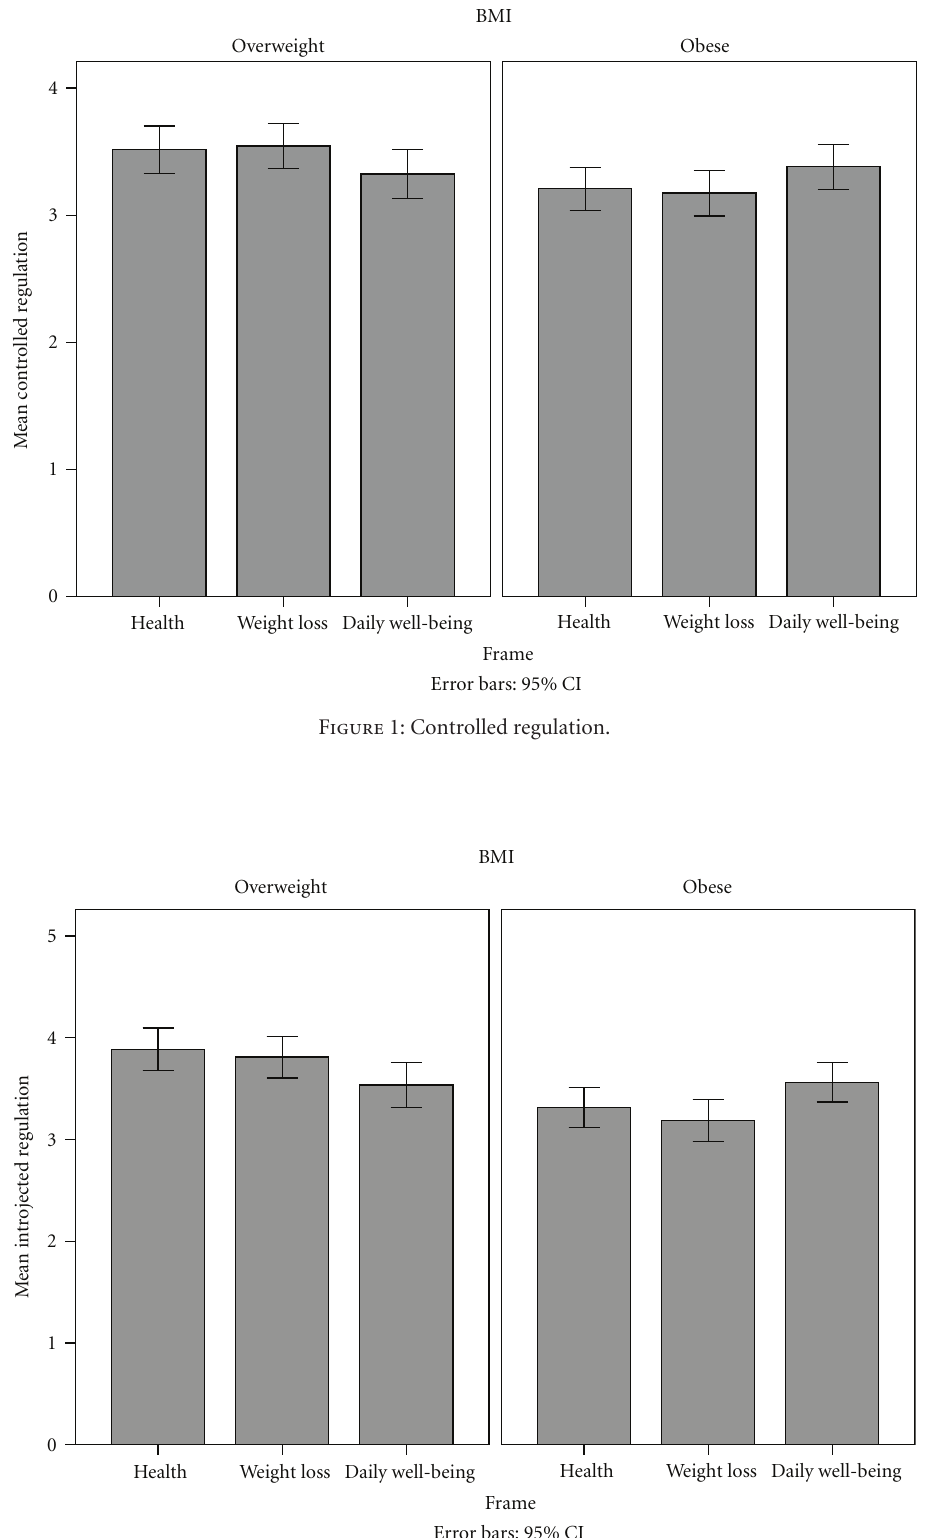
Figure 2: Introjected